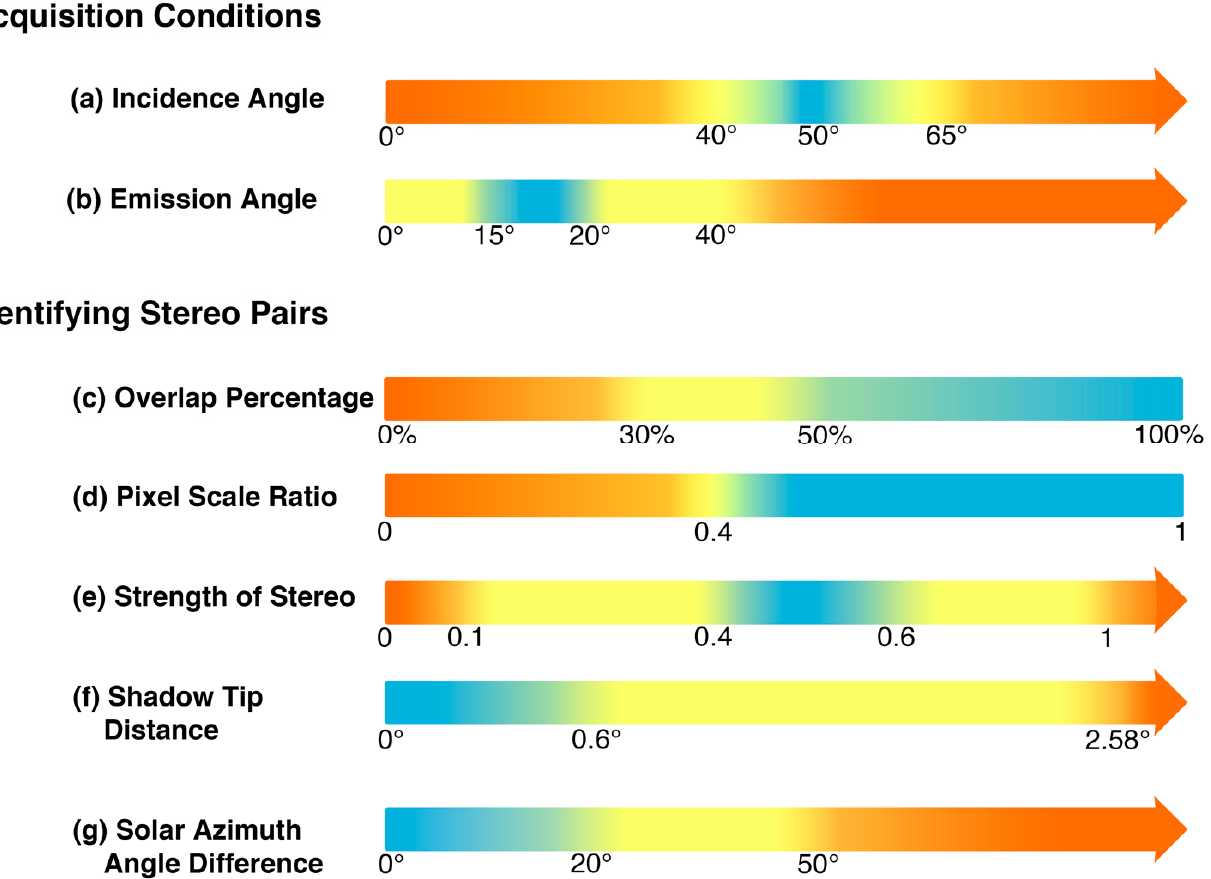
Figure 2. Criteria for choosing NAC and WAC images to produce stereo pairs (blue indicates optimal conditions, yellow is acceptable, and red is not serviceable). The values shown here are adapted from Becker et al. [30].